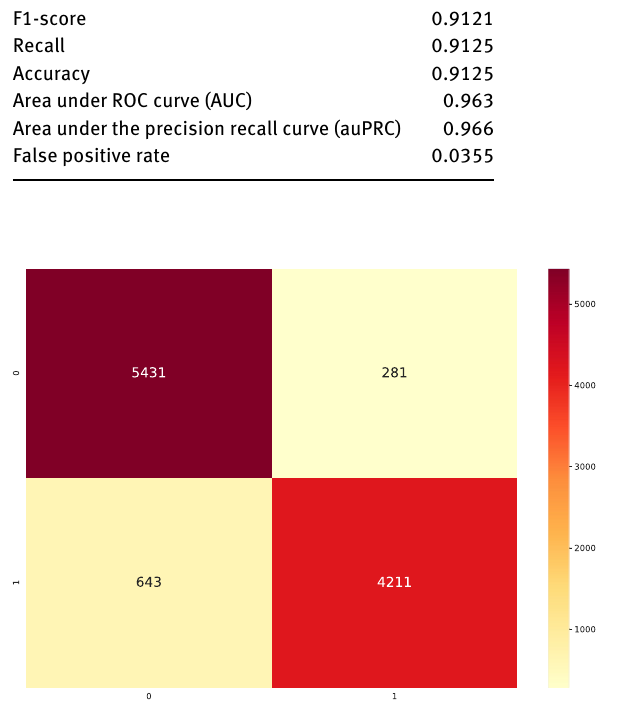
Figure 8: Confusion matrix performed with the test dataset produced by the FNN with binary classification (two-label